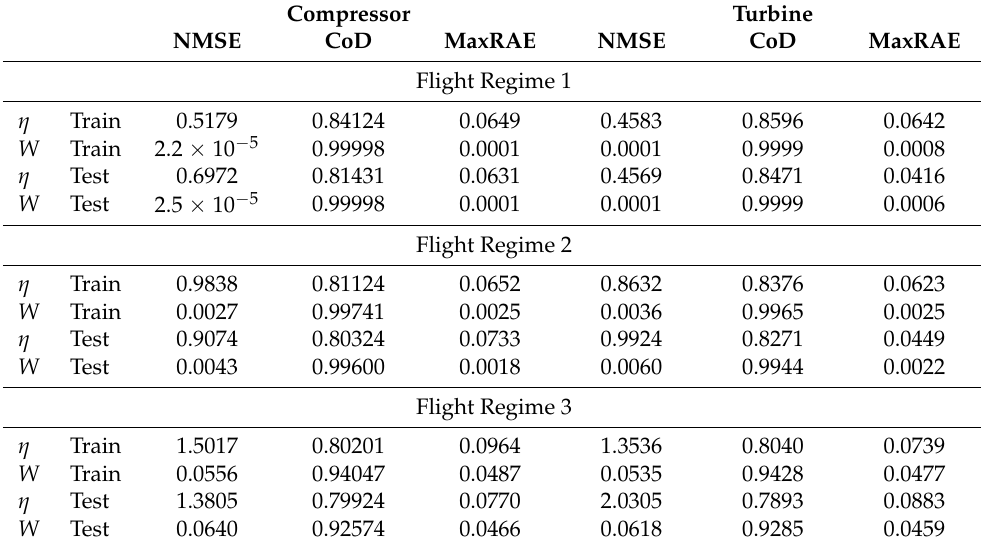
Table 6. ELM—metrics for reduced input vectors 3 and 4.